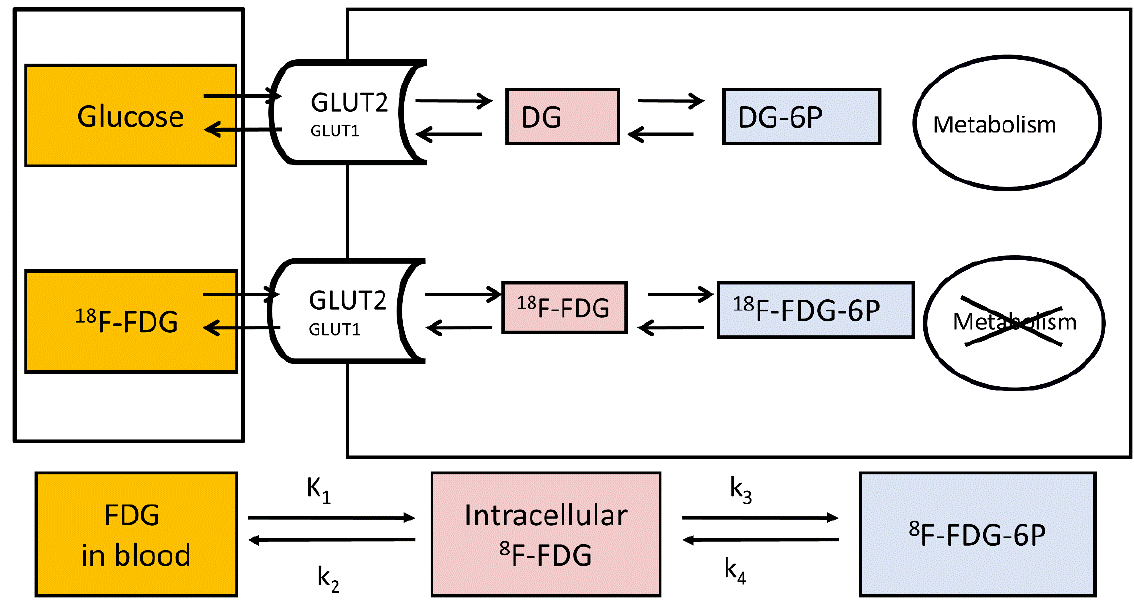
Figure 2. Measurement of hepatic glucose metabolism using 18F-FDG. K 1 : clearance from blood to cell (mL of blood/min/cm 3 of liver tissue); k 2 : back flux of 18 F-FDG (min −1 ); k 3 : phosphorylation of 18 F-FDG to 18 F-FDG-6-phosphate (min −1 ); and k 4 : dephosphorylation of 18 F-FDG-6-phosphate to 18 F-FDG (min −1 ).